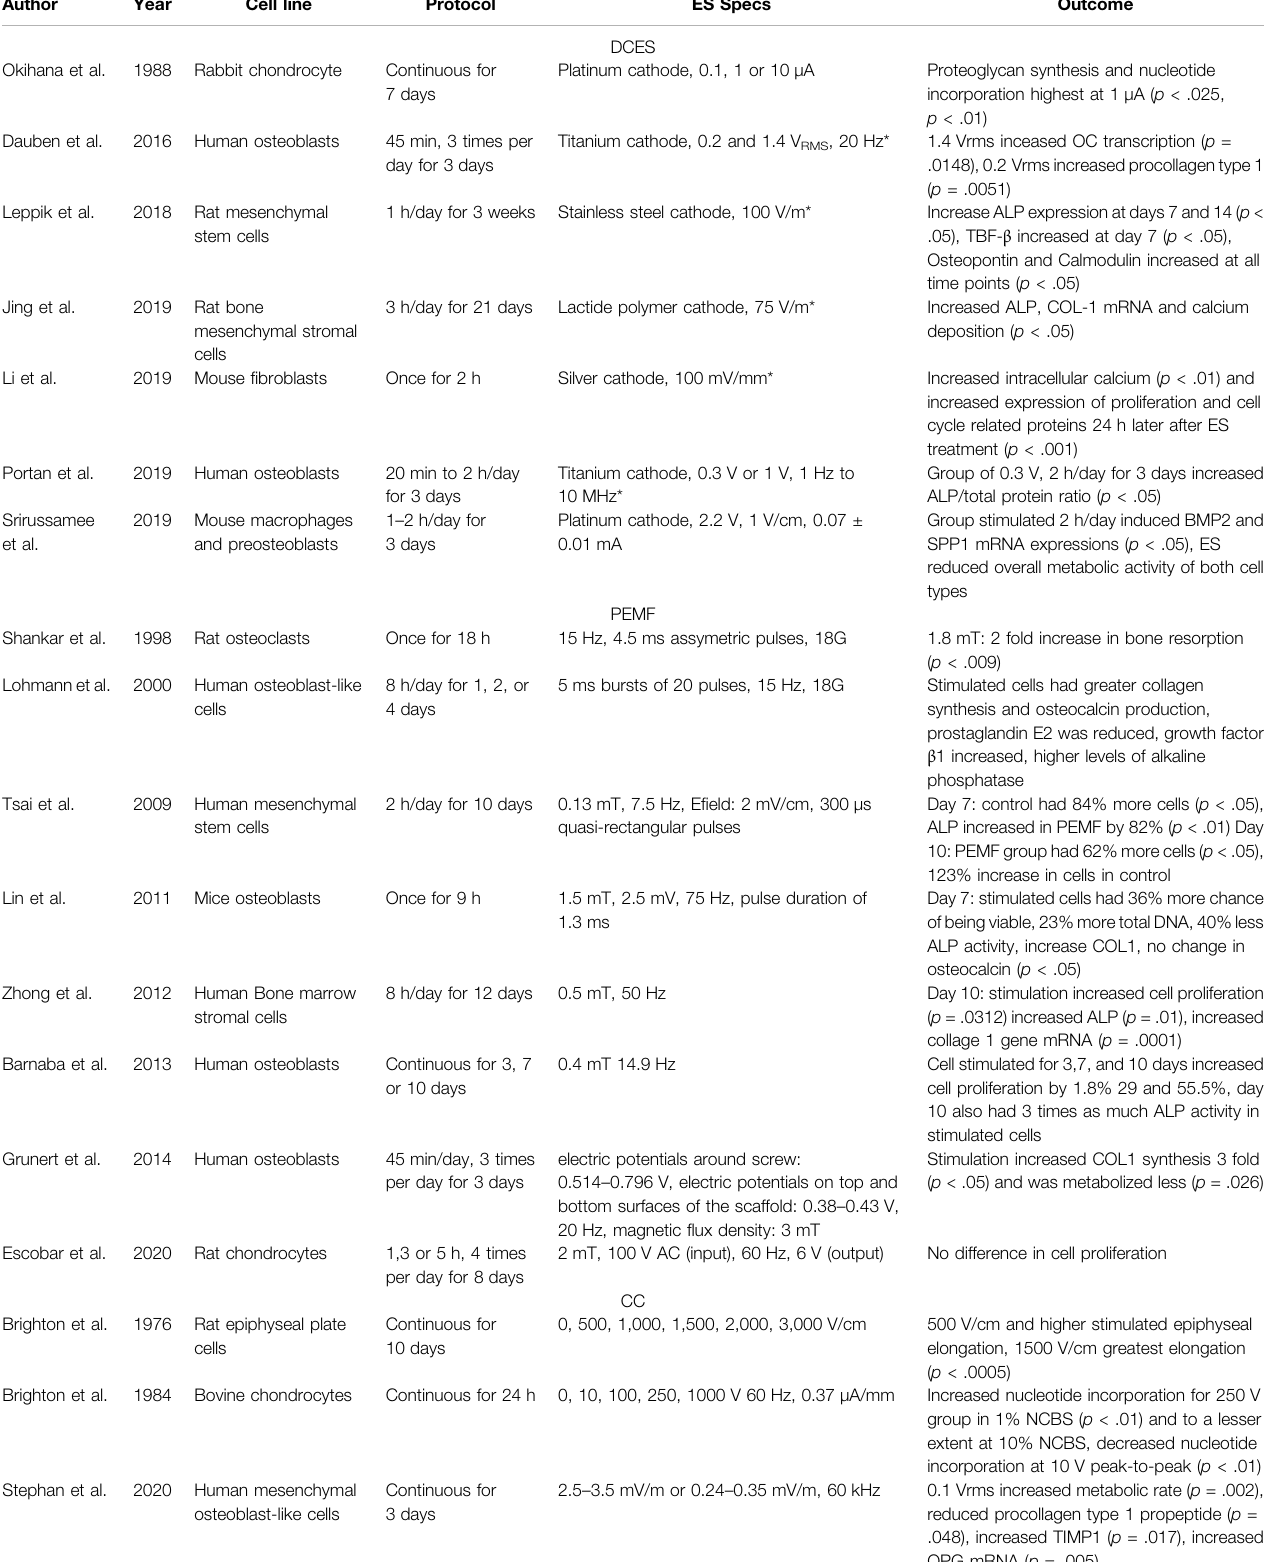
TABLE 1 | This table presents the cell line studied, stimulation protocols, device speci fi cations, and outcomes of in vitro studies included in our